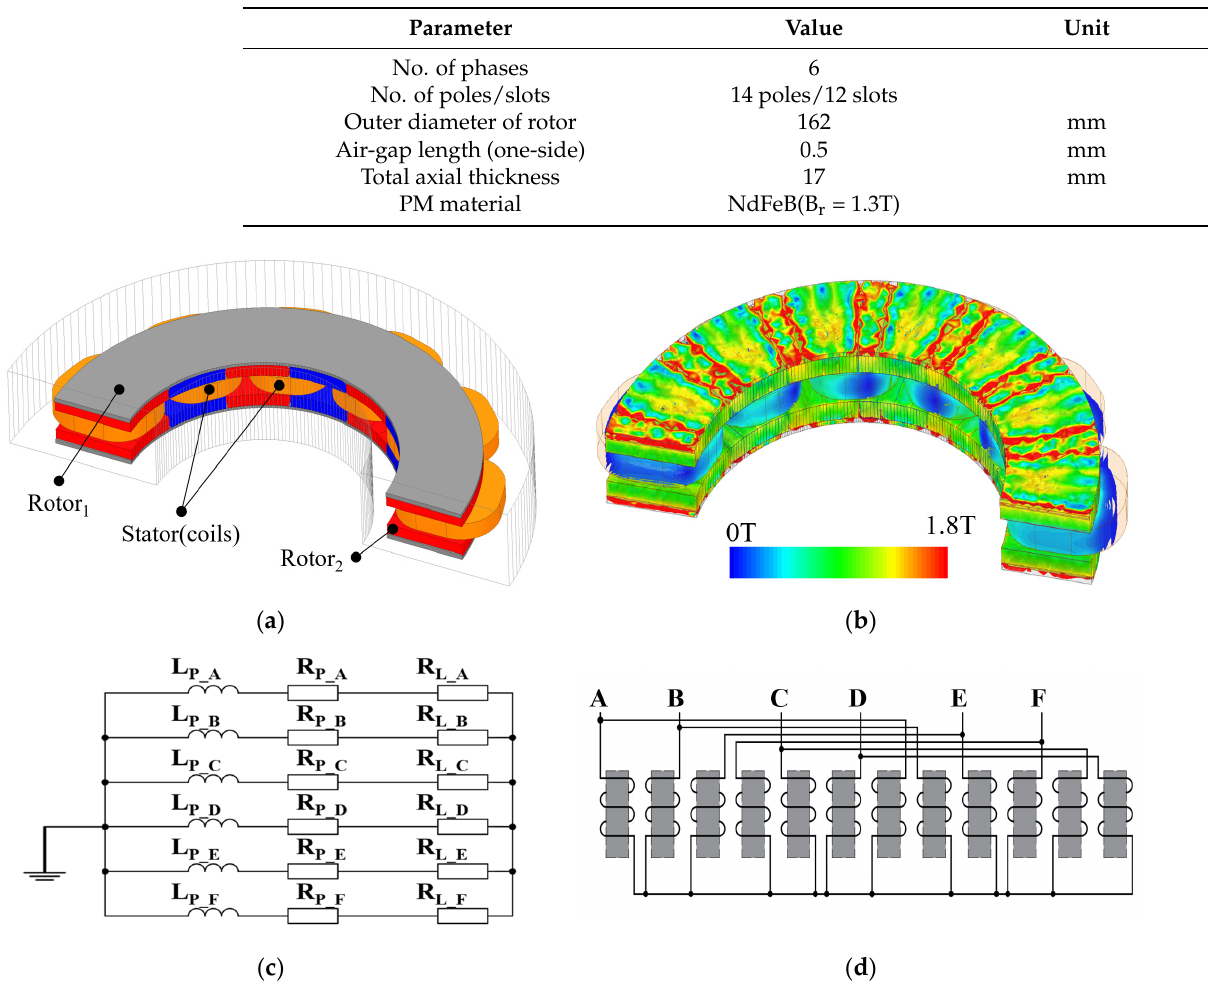
Figure 2. Three dimensional FEM analysis model for AFPM generator: ( a ) analysis periodic model, ( b ) flux density distribution, ( c ) external load-resistance circuit, and ( d ) six-phase winding pattern for stator.